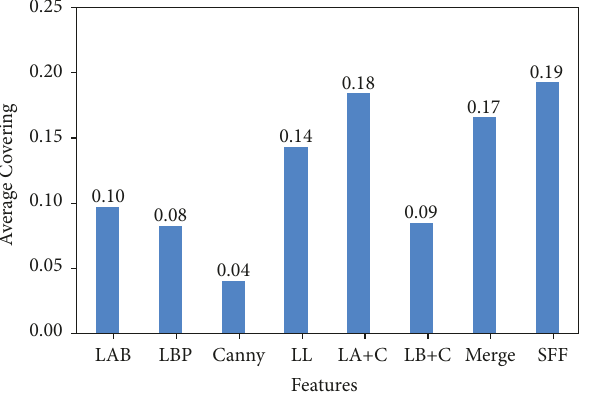
Figure 5: Average AARI of training data with different